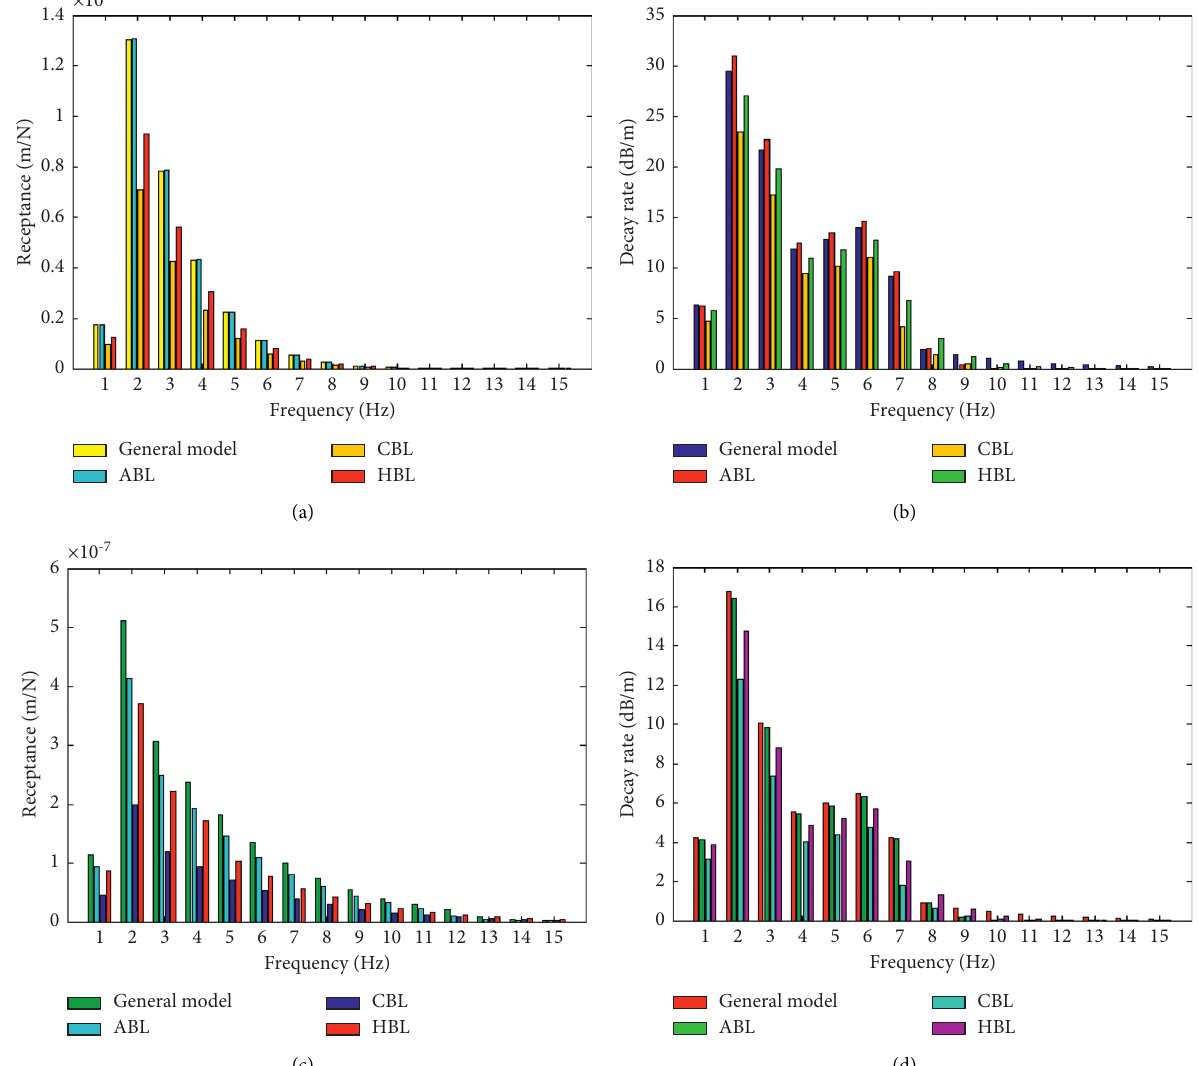
Figure 12: The effect of modulus and thickness on receptance and decay rate in layers under load amplitude of 20 tons: (a) modulus change behavior of the slab track layers under receptance, (b) modulus change behavior of the slab track layers under decay rate, (c) thickness change behavior of the slab track layers under receptance, and (d) thickness change behavior of the slab track layers under decay rate. 0.00.51.01.52.02.53.0